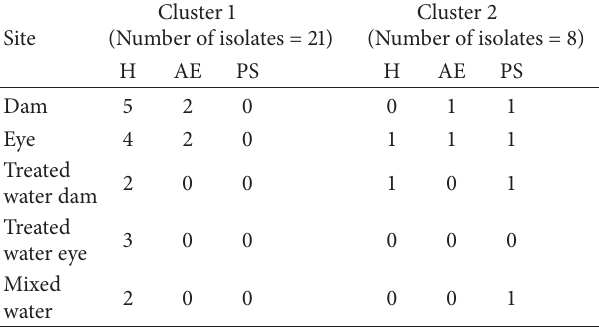
Table 10: Number of heterotrophic bacteria (H), Pseudomonas (PS), and Aeromonas (AE) isolated from different sites within the various clusters.